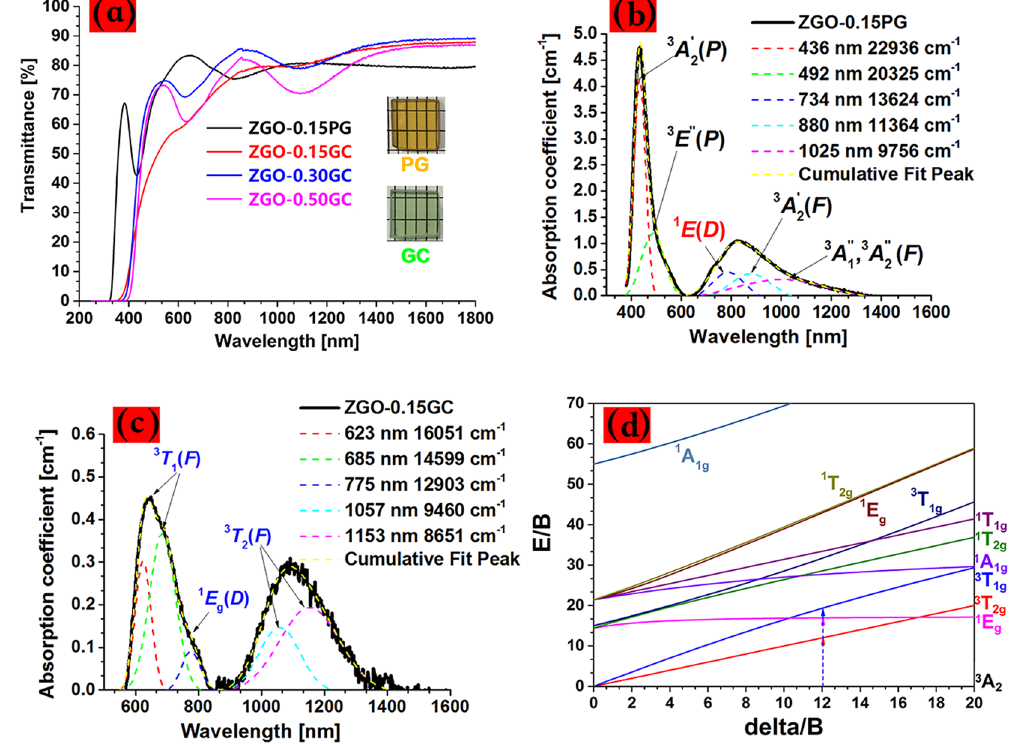
Figure 2. ( a ) Transmission spectra of the ZGO glasses and GCs of varying NiO; Absorption spectra of the ZGO-0.15PG glass ( b ) and ZGO-0.15GC glass ceramic ( c ) obtained after subtracting the background absorption. The absorption bands can be well fitted by Gauss function, and those related to 6 Ni, 5 Ni, 4 Ni are indicated by blue, black and red colors, respectively; ( d ) Tanabe-Sugano (TS) diagram for the octehedrally coordinated Ni 2 + investigated in the